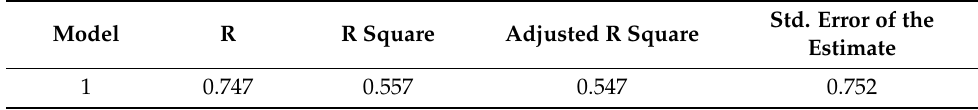
Table 8. Multilinear Regression Test Results/ANOVA a . Model Regression 148.118